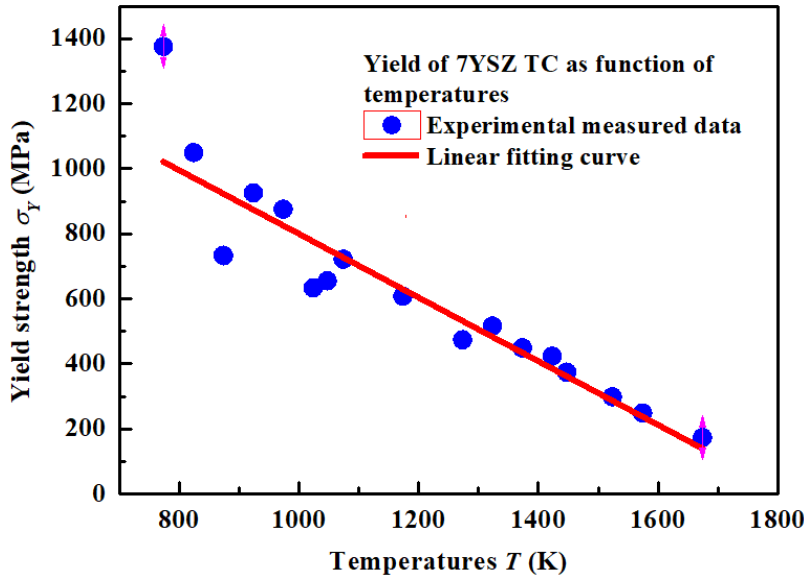
Figure 10. The yield strength of 7YSZ as a function of temperature [44].